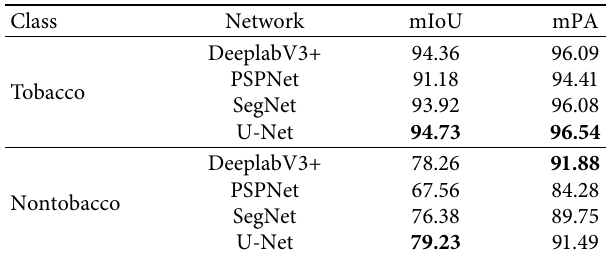
Table 2: The accuracy evaluation indicators of tobacco and